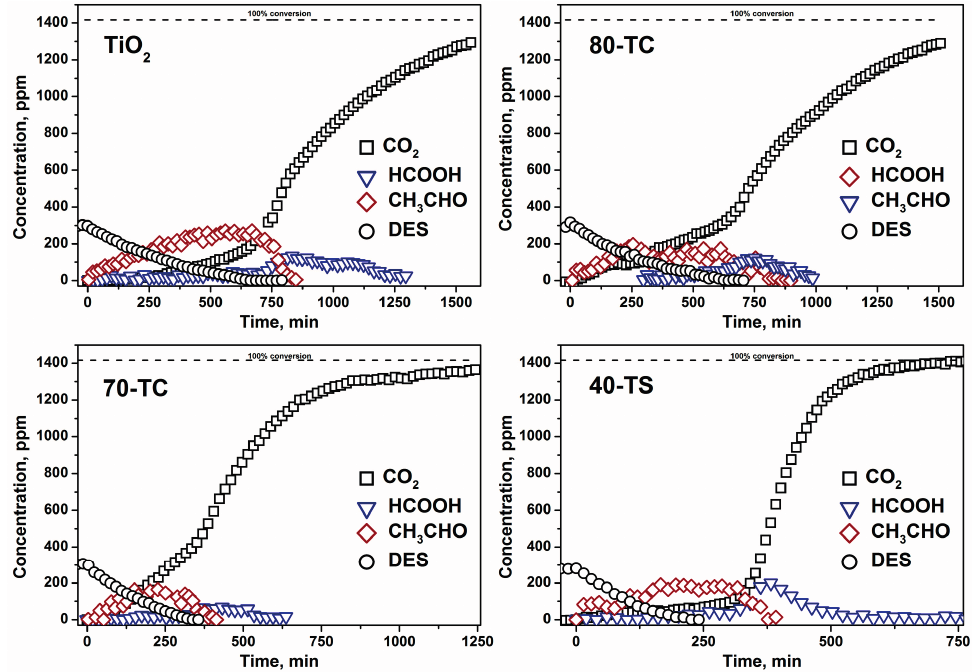
Figure 7. Kinetics of 0.5 μ L DES PCO in the static reactor during the third cycle over the pure TiO 2 , 80-TC, 70-TC and 40-TS